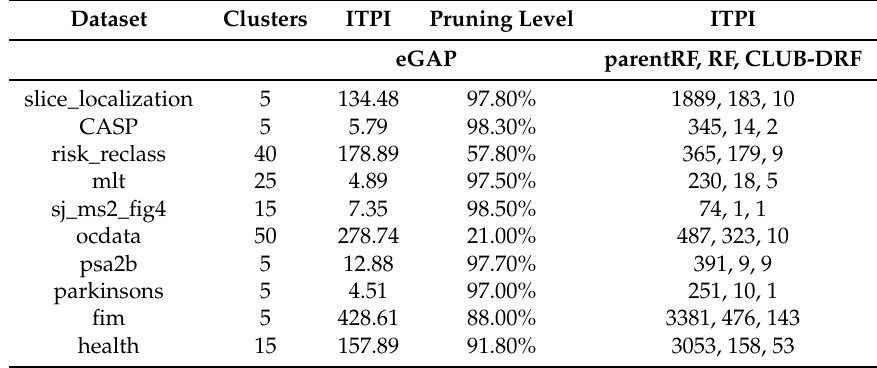
Table 8. ITPI and pruning level performance metrics of eGAP vs. parentRF, RF, and CLUB-DRF on regression